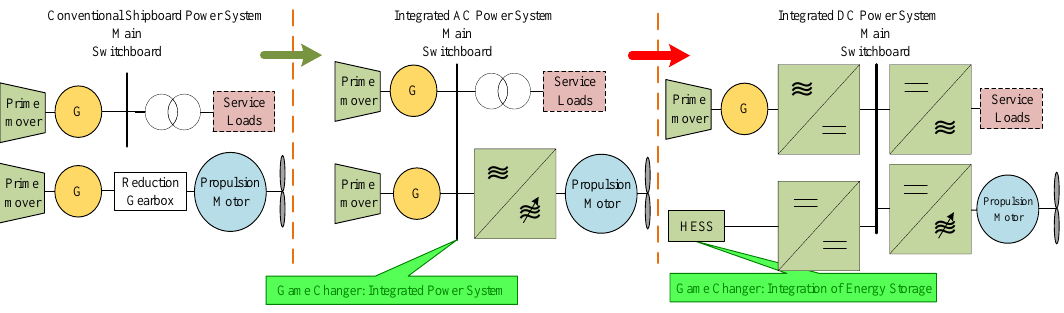
Figure 1. Evolution of Shipboard Power